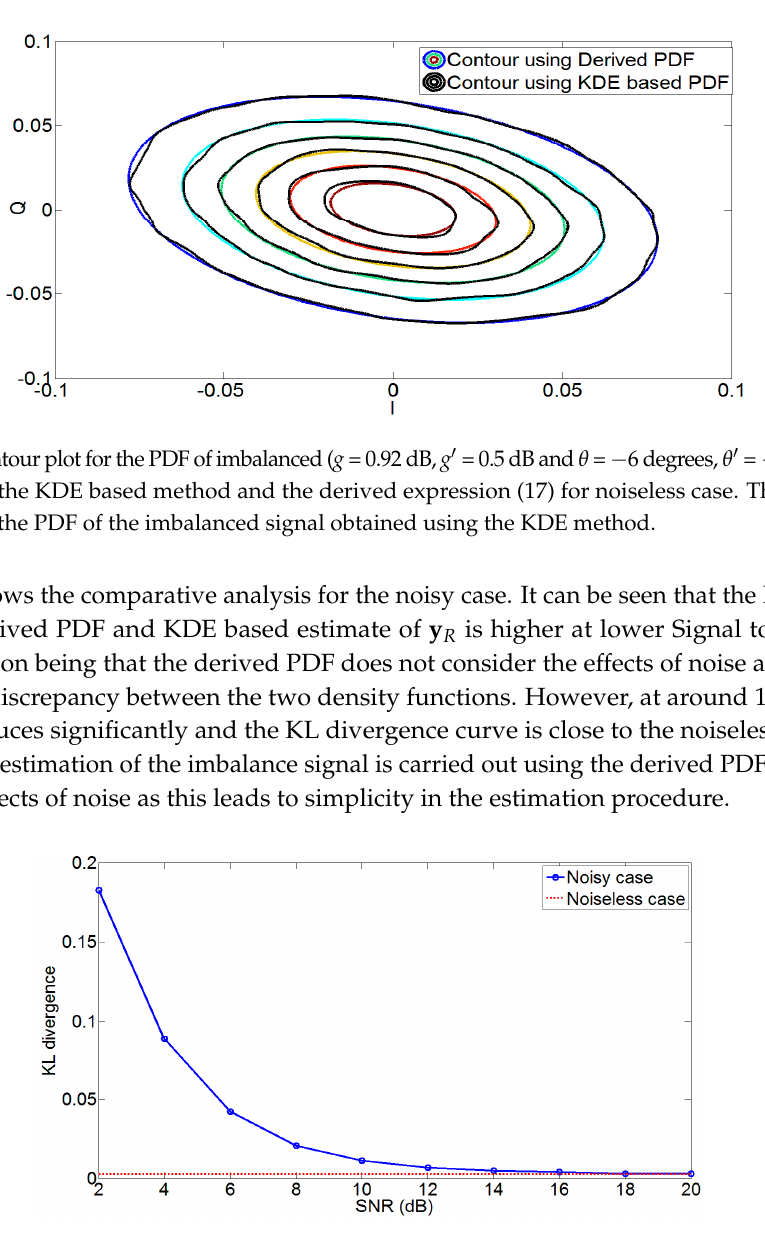
Figure 4. Kullback-Leibler (KL) divergence between KDE based estimate of y R and derived PDF for WCDMA 1111 signal. The dotted line shows the KL divergence for the noiseless case while the solid line includes the effect of noise.